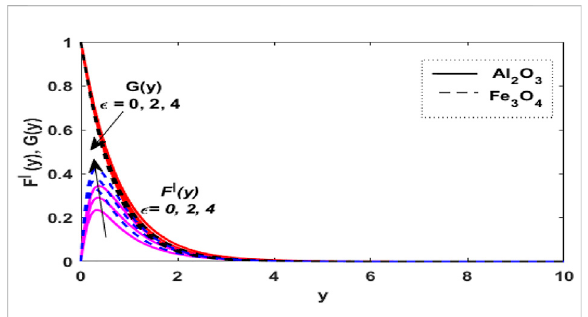
FIGURE 4 Characteristics of ∈ on F I (y) and G(y), when ϕ = 0.01, M = 1, and Pr =